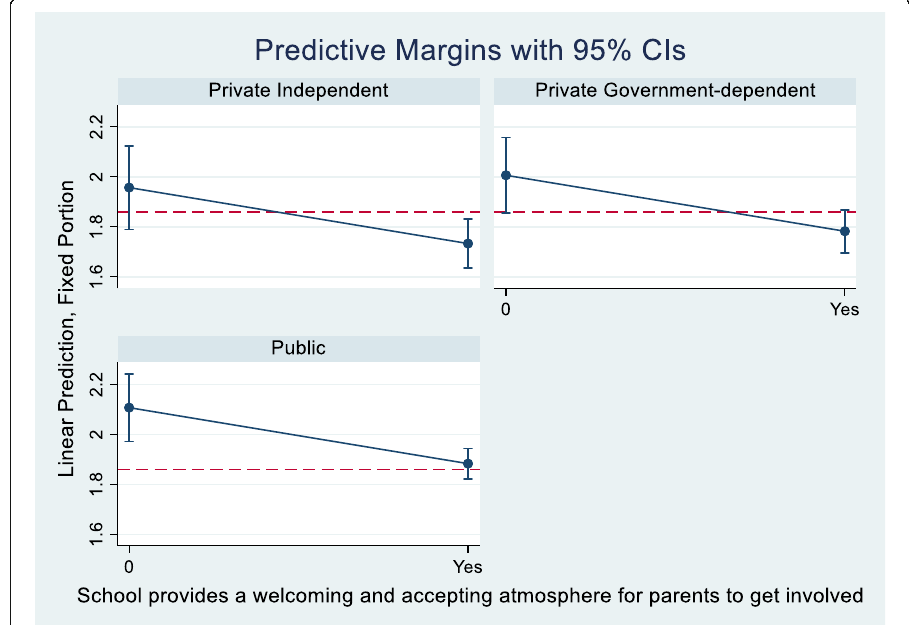
Fig. 1 Improvements in reducing learning climate barriers associated with a welcoming and accepting atmosphere for parental involvement. Graphic computed using pooled model #5. The red dashed line denotes the average score of learning climate associated with teacher behavior,